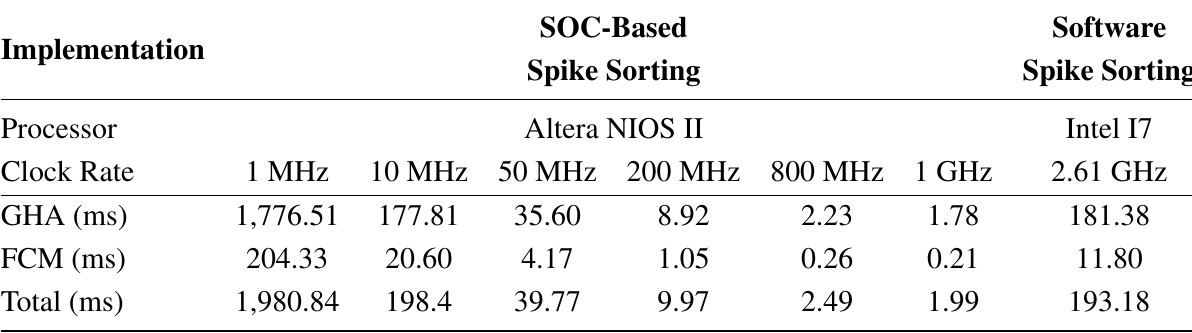
Table 7. The training time of the proposed spike sorting system for various clock